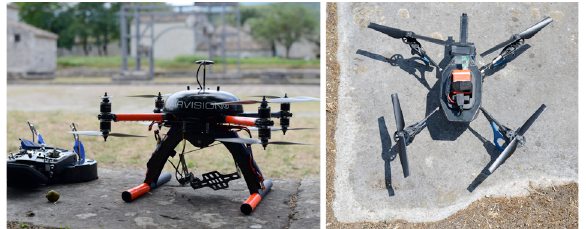
Figure 5. The two different UAV's systems